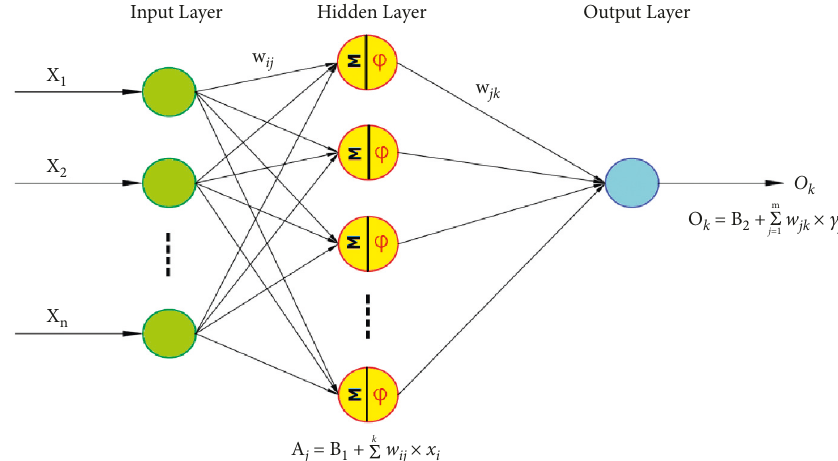
Figure 1: Architecture of MLP